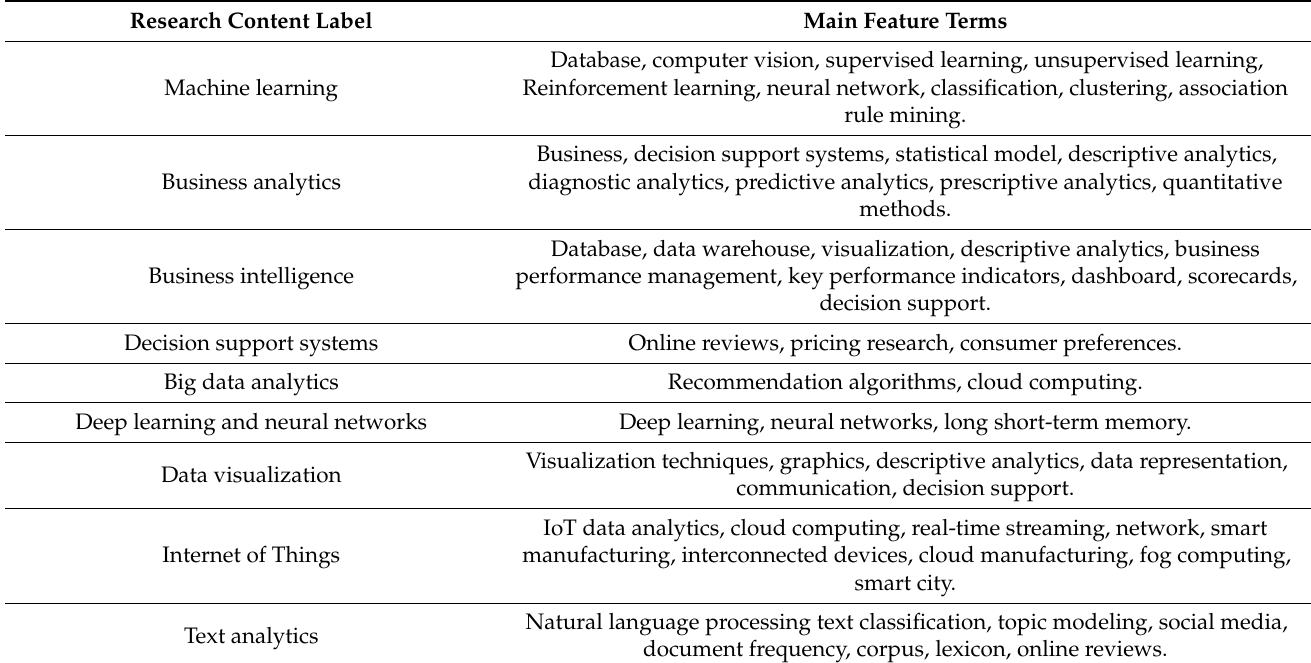
Table 6. Annotation features of disciplinary categories in data science and